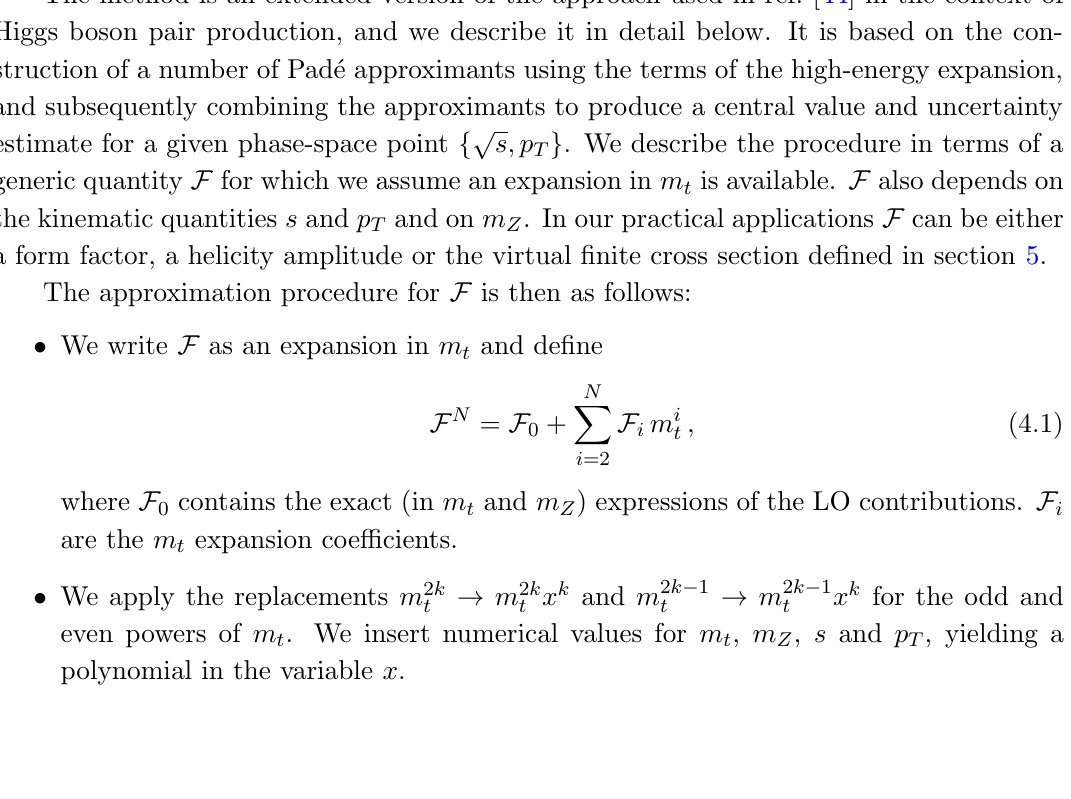
ZZ for (cid:18) = (cid:25)= 2, normalized to the exact ! and m 0 , m 2 and m 4 t Z Z Z